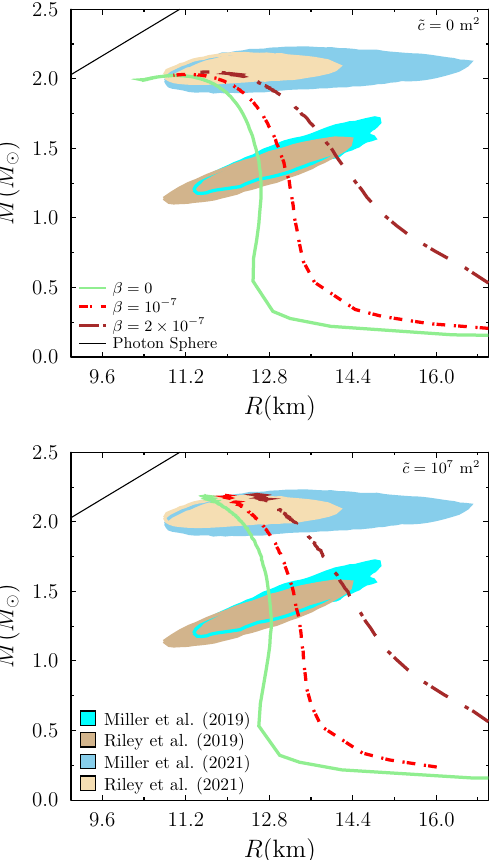
Fig. 3 The EoS of NS shown in panel ( a ) and the anisotropy fac- tor σ , shown in panel ( b ), is adjusted by multiplying σ with f = exp [− ( P / P c − 0 . 5 ) 20 /( 0 . 4 ) 20 ] (shown in the inset)